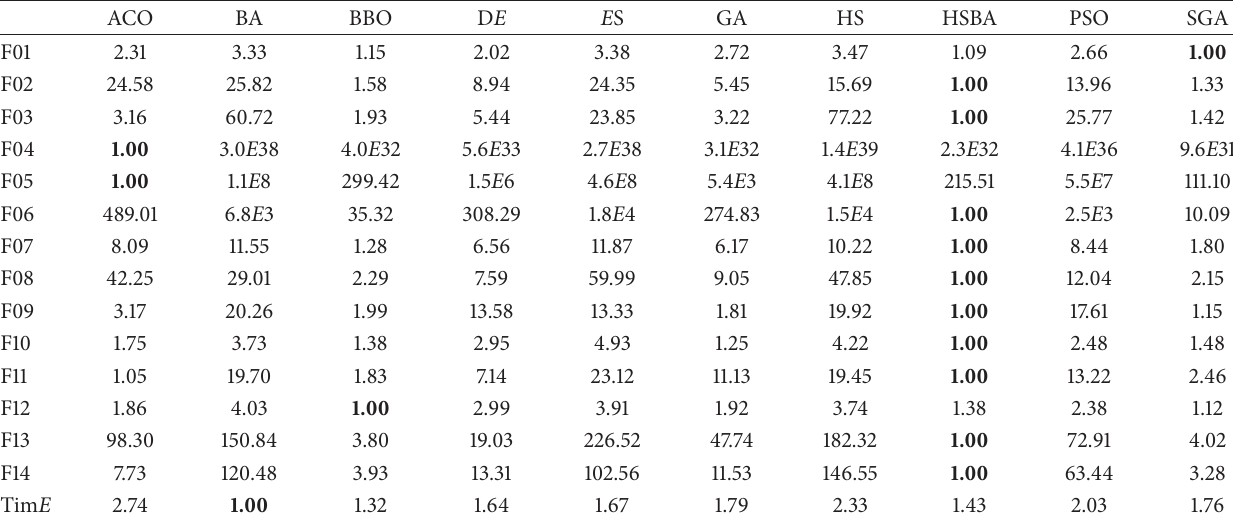
Table 3: Mean normalized optimization results in fourteen benchmark functions. The values shown are the minimum objective function values found by each algorithm, averaged over 100 Monte Carlo